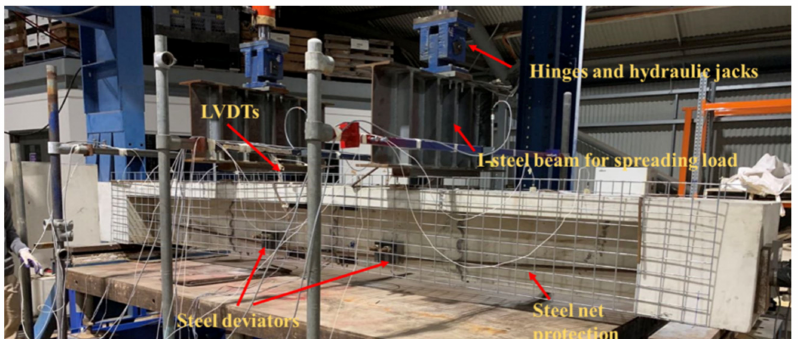
Figure 7. Typical experimental setup for static loading test.